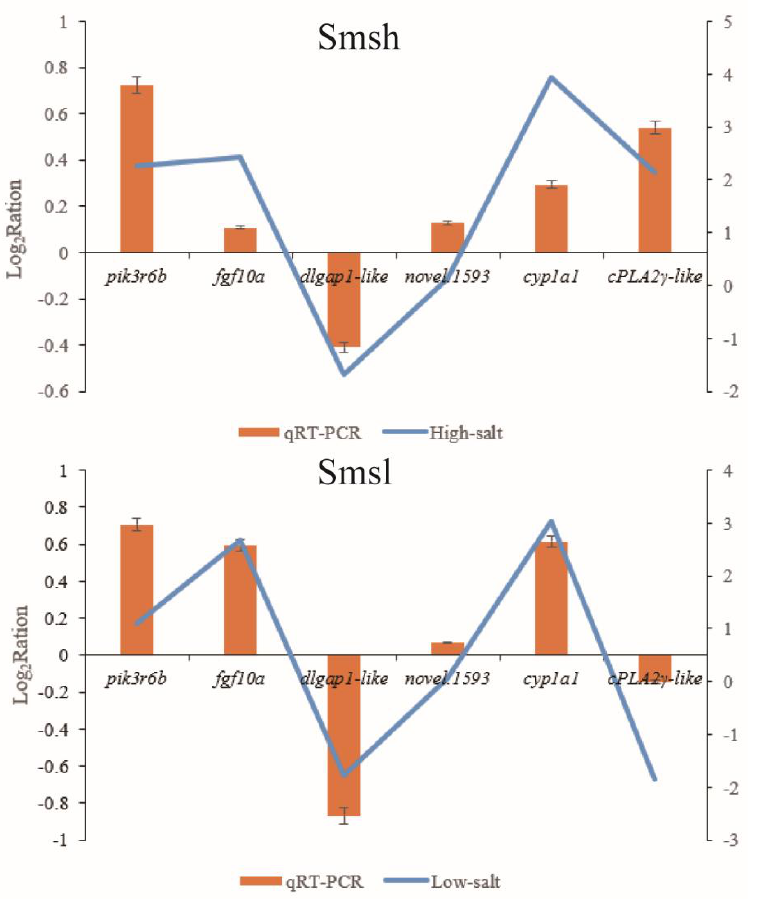
Figure 7 . Validation of six significantly differentially expressed genes by qRT-PCR. Figure 7. Validation of six significantly differentially expressed genes by